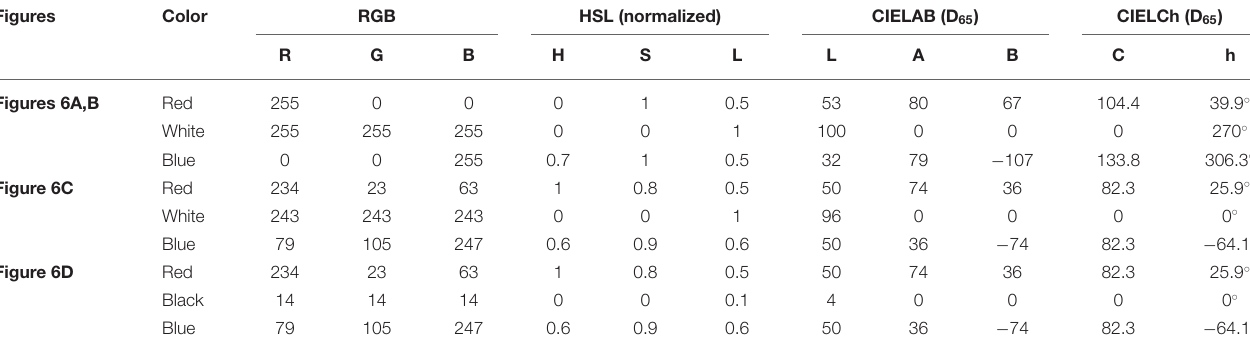
TABLE 2 | Figures 6A–D Gradient Color Values. Figures